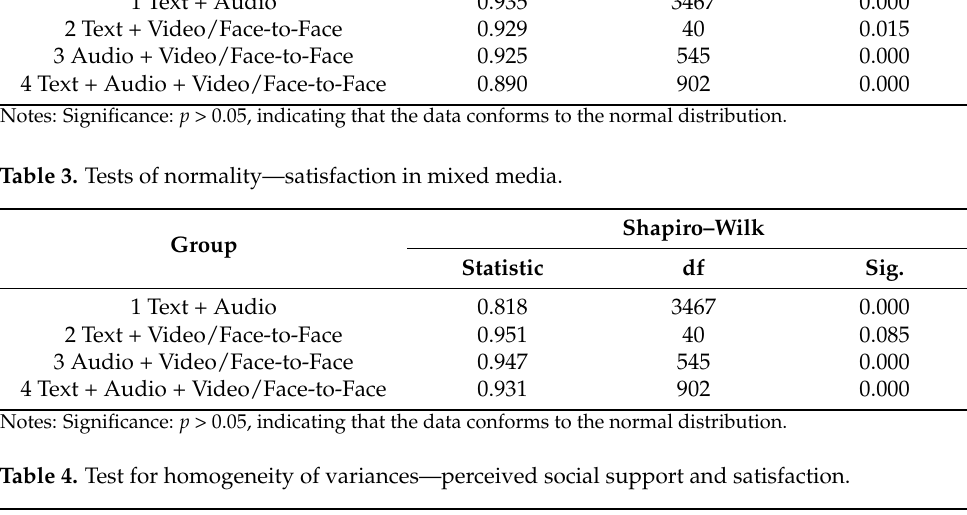
Table 2. Tests of normality—perceived social support in mixed media. Shapiro–Wilk Group Statistic df Sig.